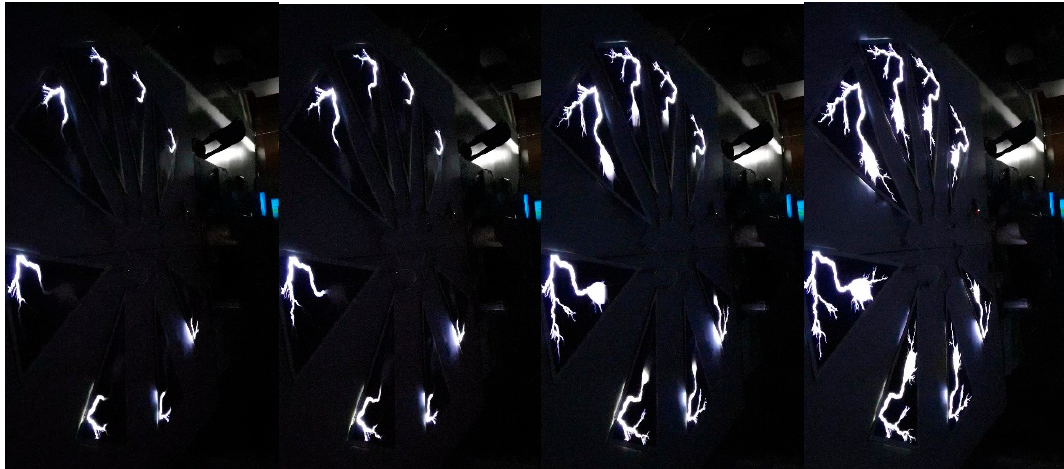
Figure 7. Bench test of finished